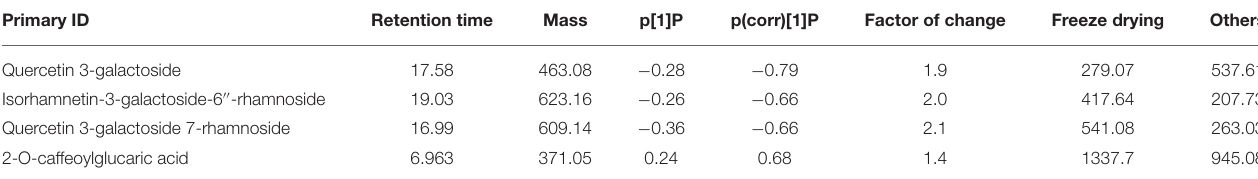
TABLE 5 | Exact mass/retention time pairs responsible for the separation of freeze-dried pumpkin leaves from the other drying